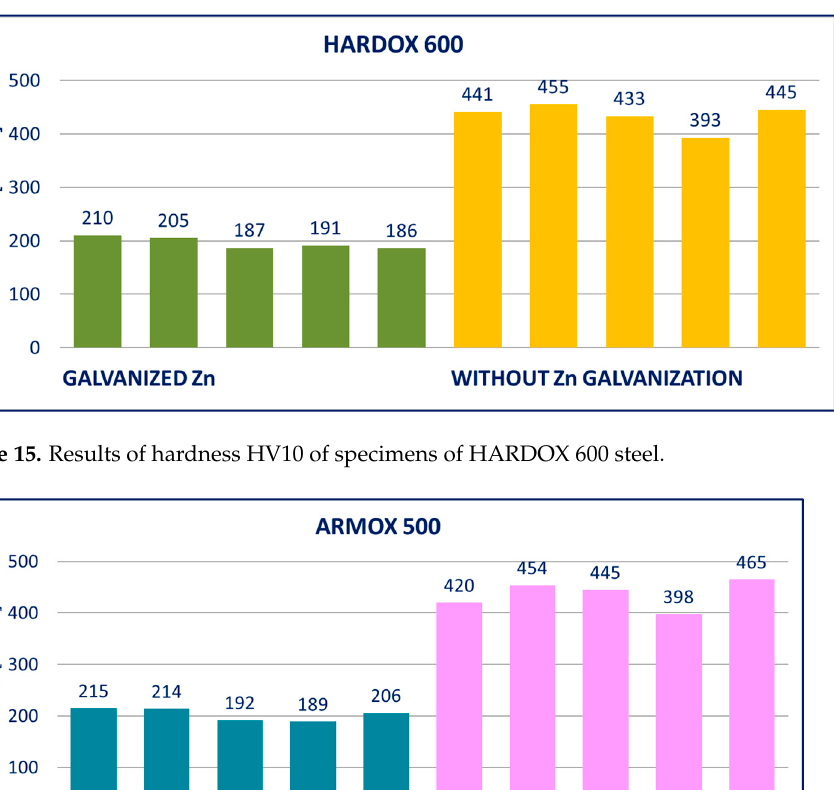
Figure 14. Results of hardness HV10 of specimens of HARDOX 500 steel.